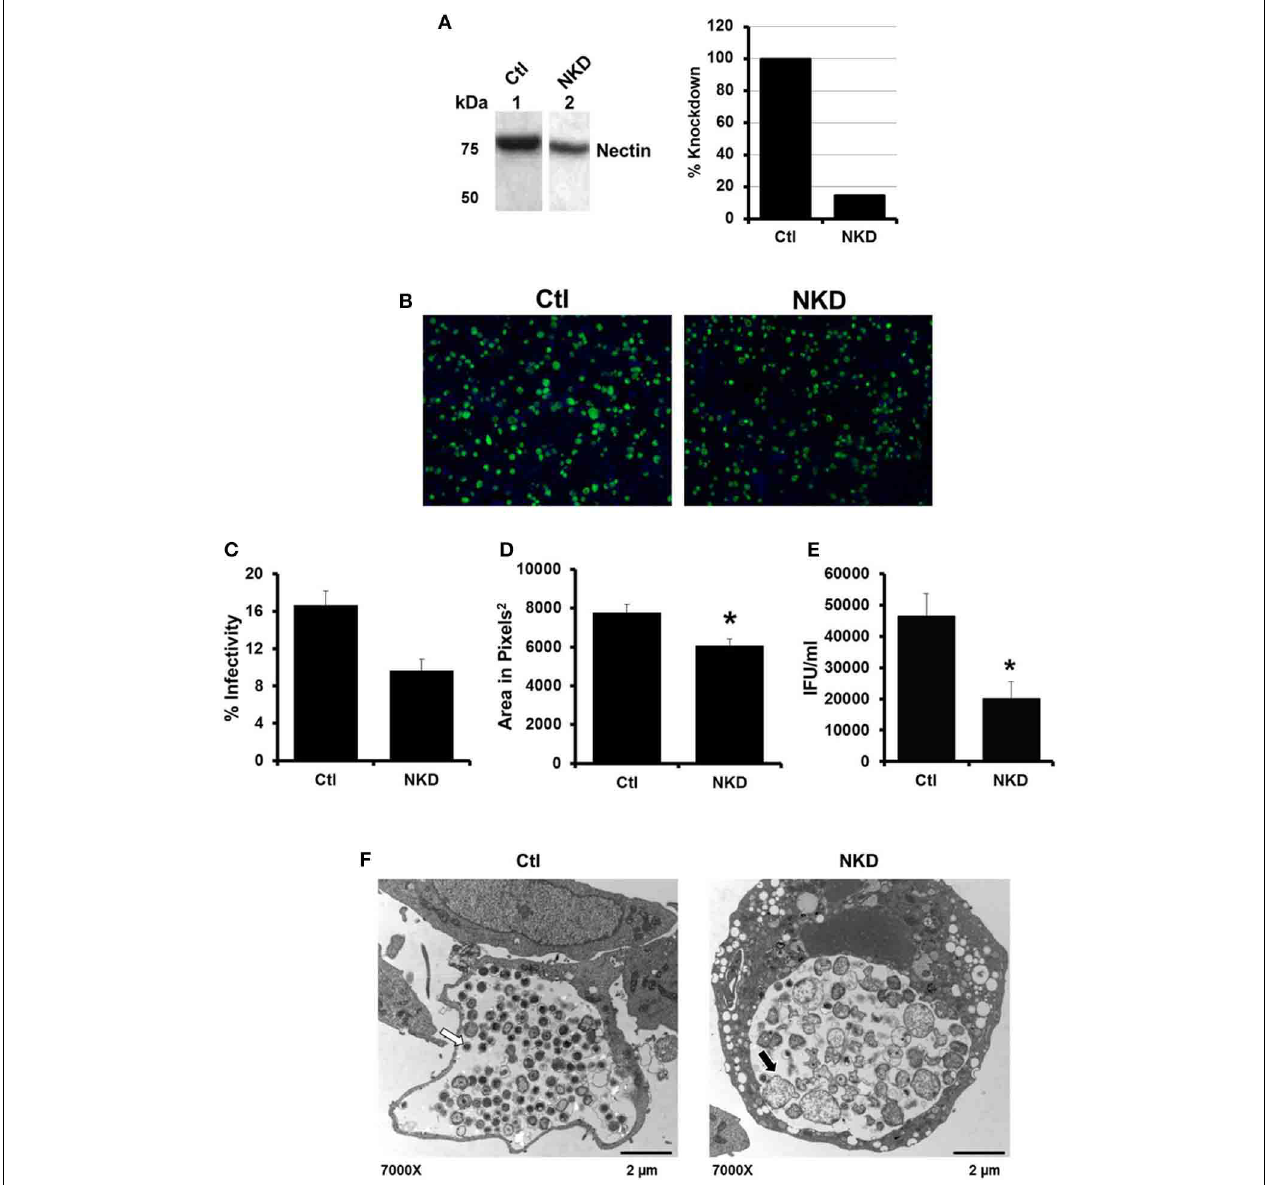
FIGURE 3 | Production of C. trachomatis infectious progeny, but not inclusion formation, is nectin-1 dependent. (A) Nectin-1 accumulation in control (Ctl, lane 1) and nectin-1 knockdown (NKD, lane 2) cell lines was verified by Western blot analysis. Intensity was normalized to total protein intensity detected by SYPRO Ruby staining (data not shown) and analyzed with Gene Tools software (Syngene). Intensity measurements are shown as percent of Ctl. (B–F) Replicate cultures of Ctl and NKD cells were infected with CtE and harvested at 48hpi for various analyses. (B) Chlamydial inclusions were stained with Pathfinder anti-chlamydial stain (green). Cell nuclei were counterstained with DAPI (blue). Images were captured at 100 ×